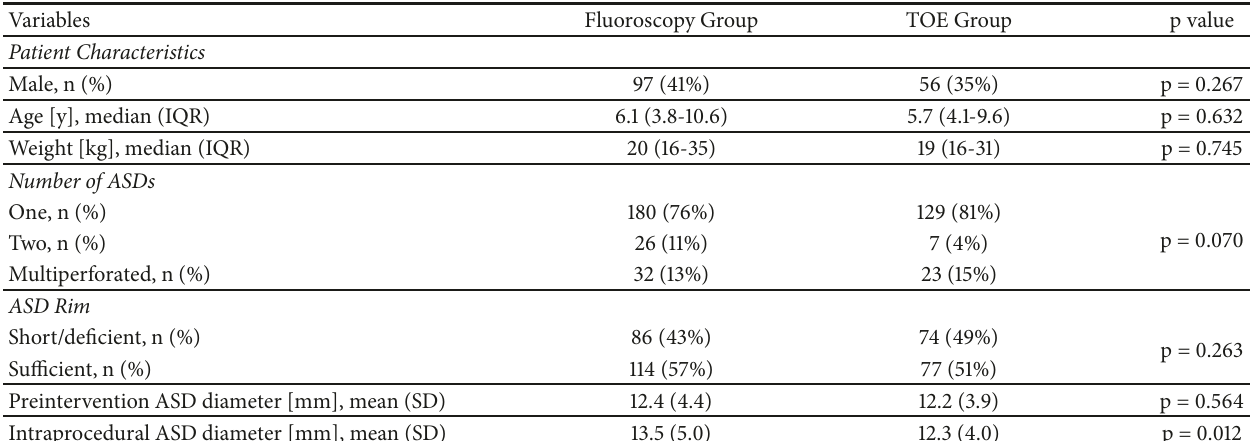
Table 1: Patients demographics and characteristics in the fluoroscopy group (n=238) and the TOE group (n=159). Preinterventionally,